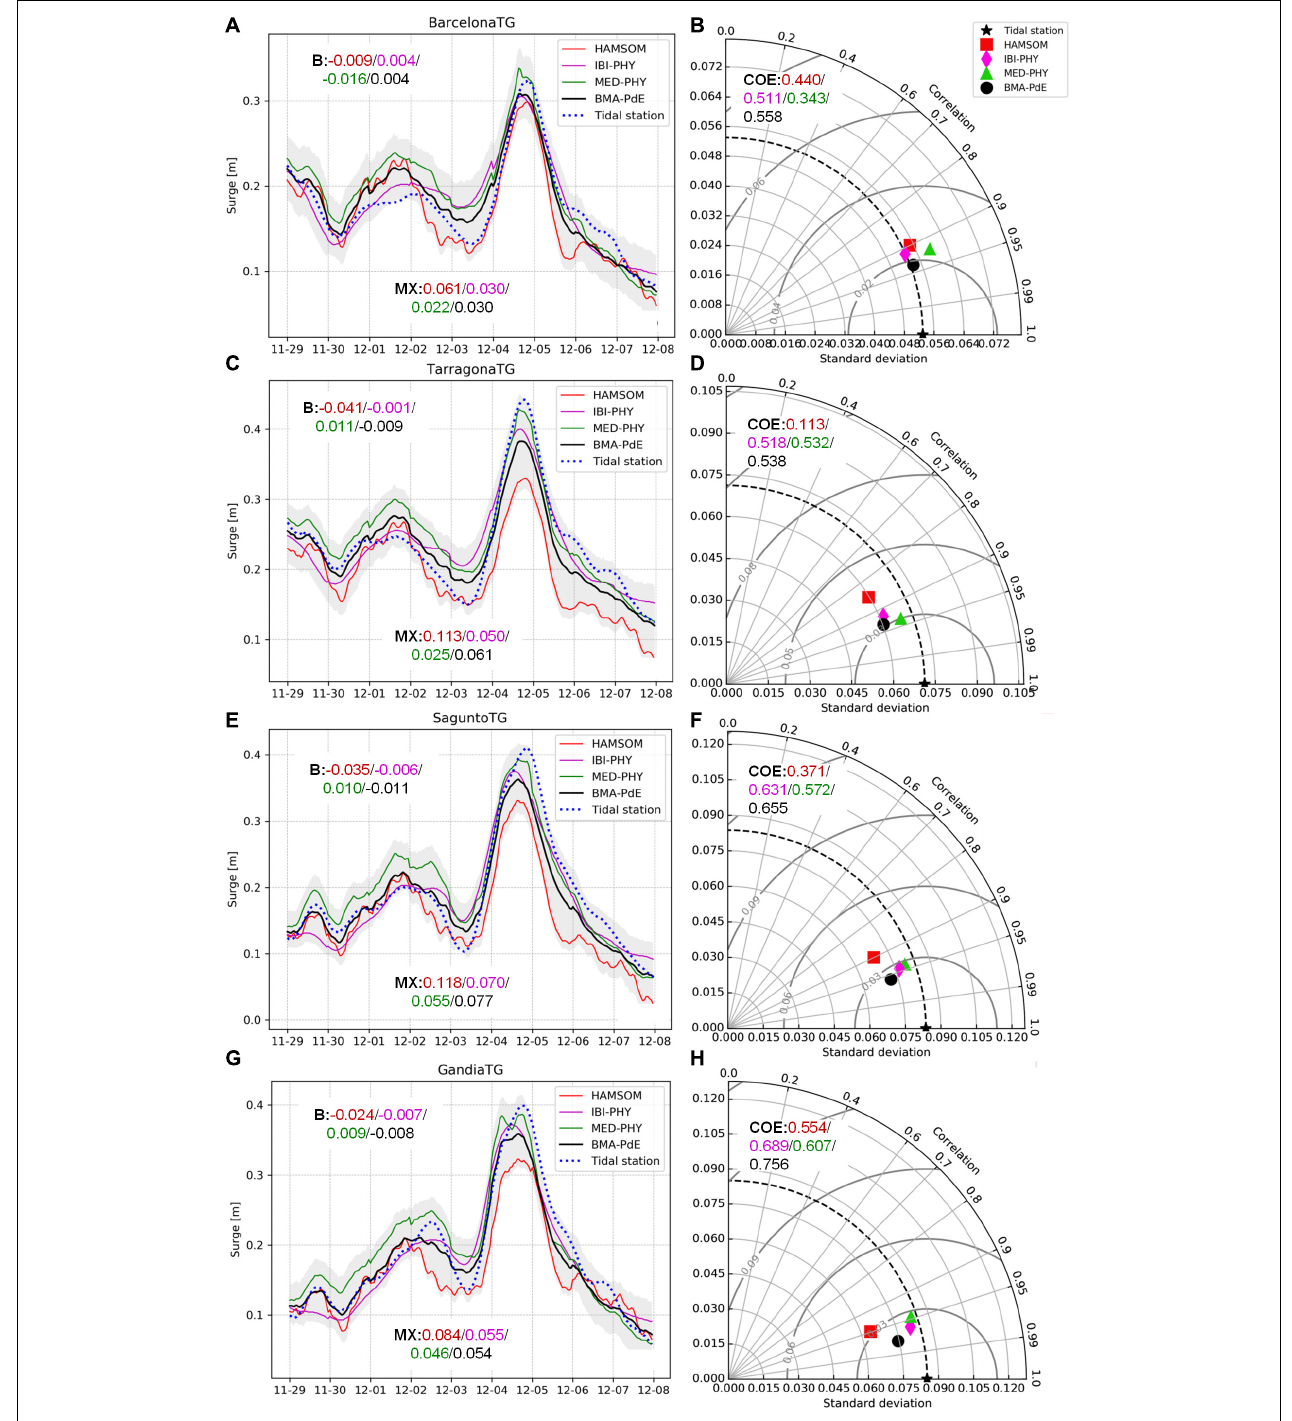
FIGURE 11 | Results of the ENSURF system at several TGs during storm Dora: Nivmar (red), IBI-MFS (magenta), MedFS (green), BMA-PdE (black), and observations (blue). Left panels: surge time series at Barcelona (A) , Tarragona (C) , Sagunto (E) , and Gandía (G) . B is the mean bias for each model, in meters (same chromatic index). MX is the maximum error, in meters. The gray areas enclose the 5-95% percentiles of the ENSURF system. Right panels: Taylor diagrams at Barcelona (B) , Tarragona (D) , Sagunto (F) , and Gandía (H) . Legend: Nivmar (red square), IBI-MFS (magenta rhombi), MedFS (green triangle), BMA (black dot). COE is the Coefficient of Efficiency for each model